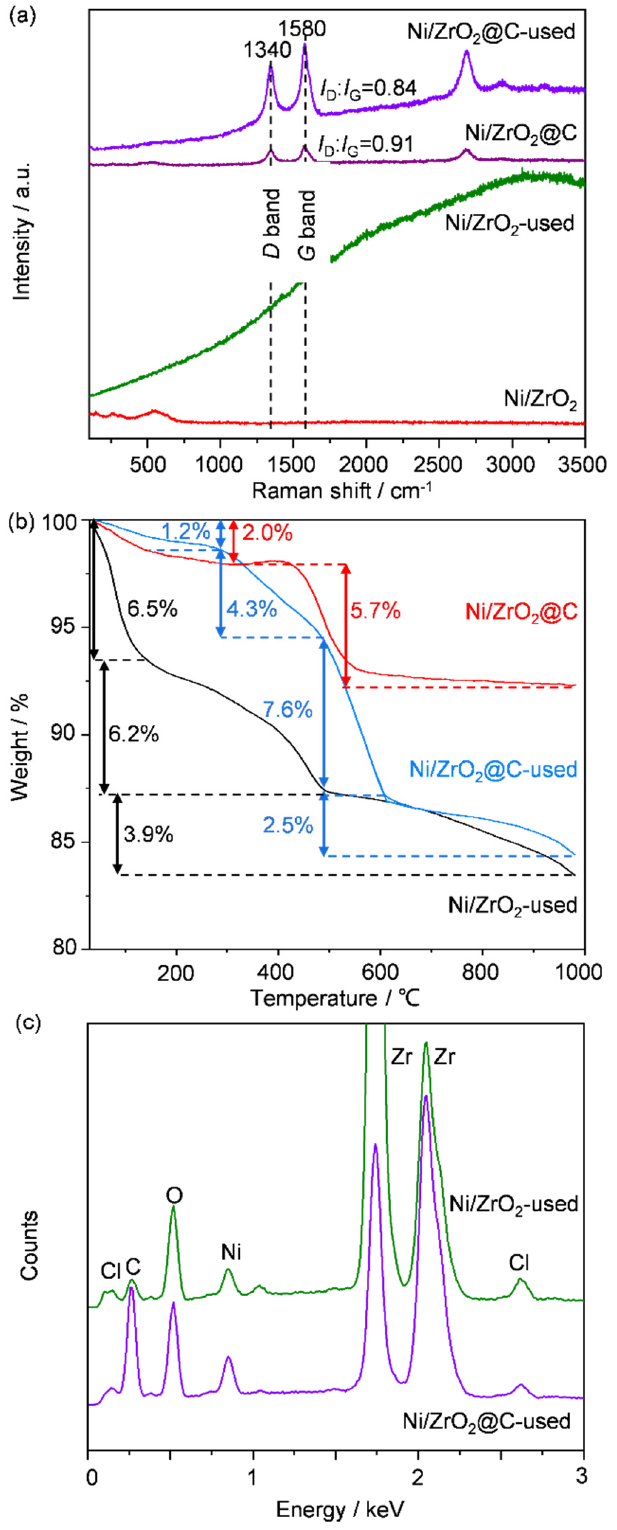
Figure 7. ( a) Raman, ( b ) TG, and ( c ) EDS analyses of Ni/ZrO 2 and Ni/ZrO 2 @C after the stability tests.